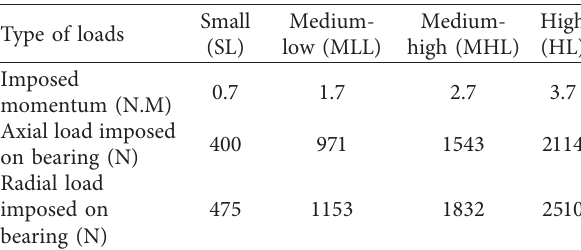
Table 2: Different loads imposed on the bearing. Type of loads